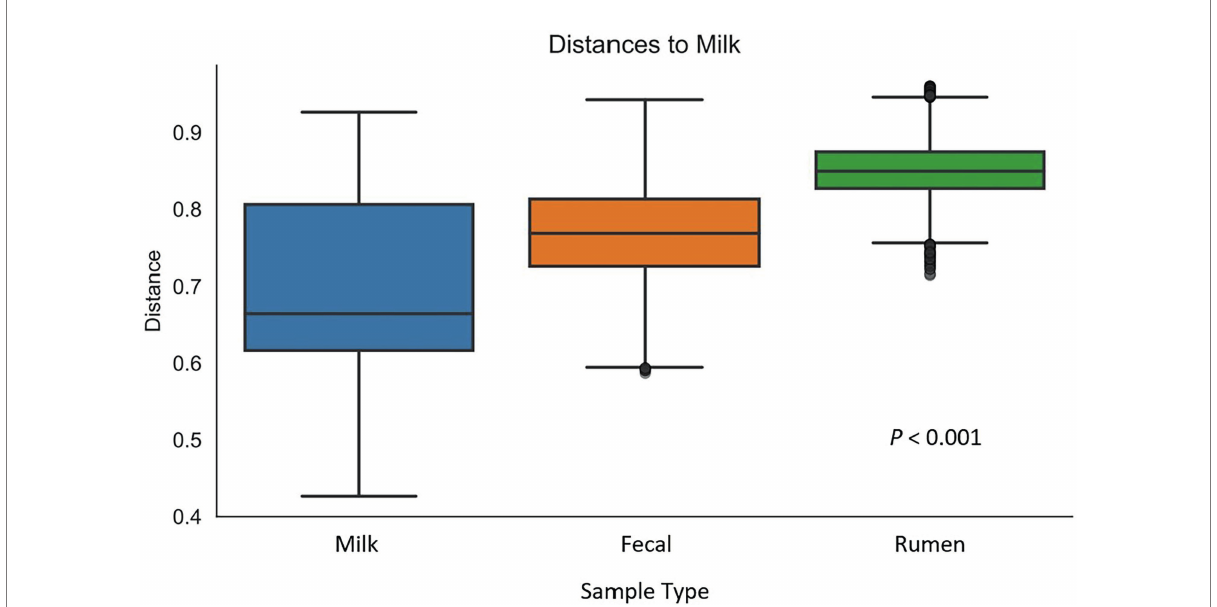
FIGURE 2 Box-and-whisker plot of unweighted UniFrac distances between milk samples ( n = 47) and rumen ( n = 51), and fecal ( n = 51) samples. Whiskers express the maximum and minimum values. Value of p indicates a difference in diversity between sample types.